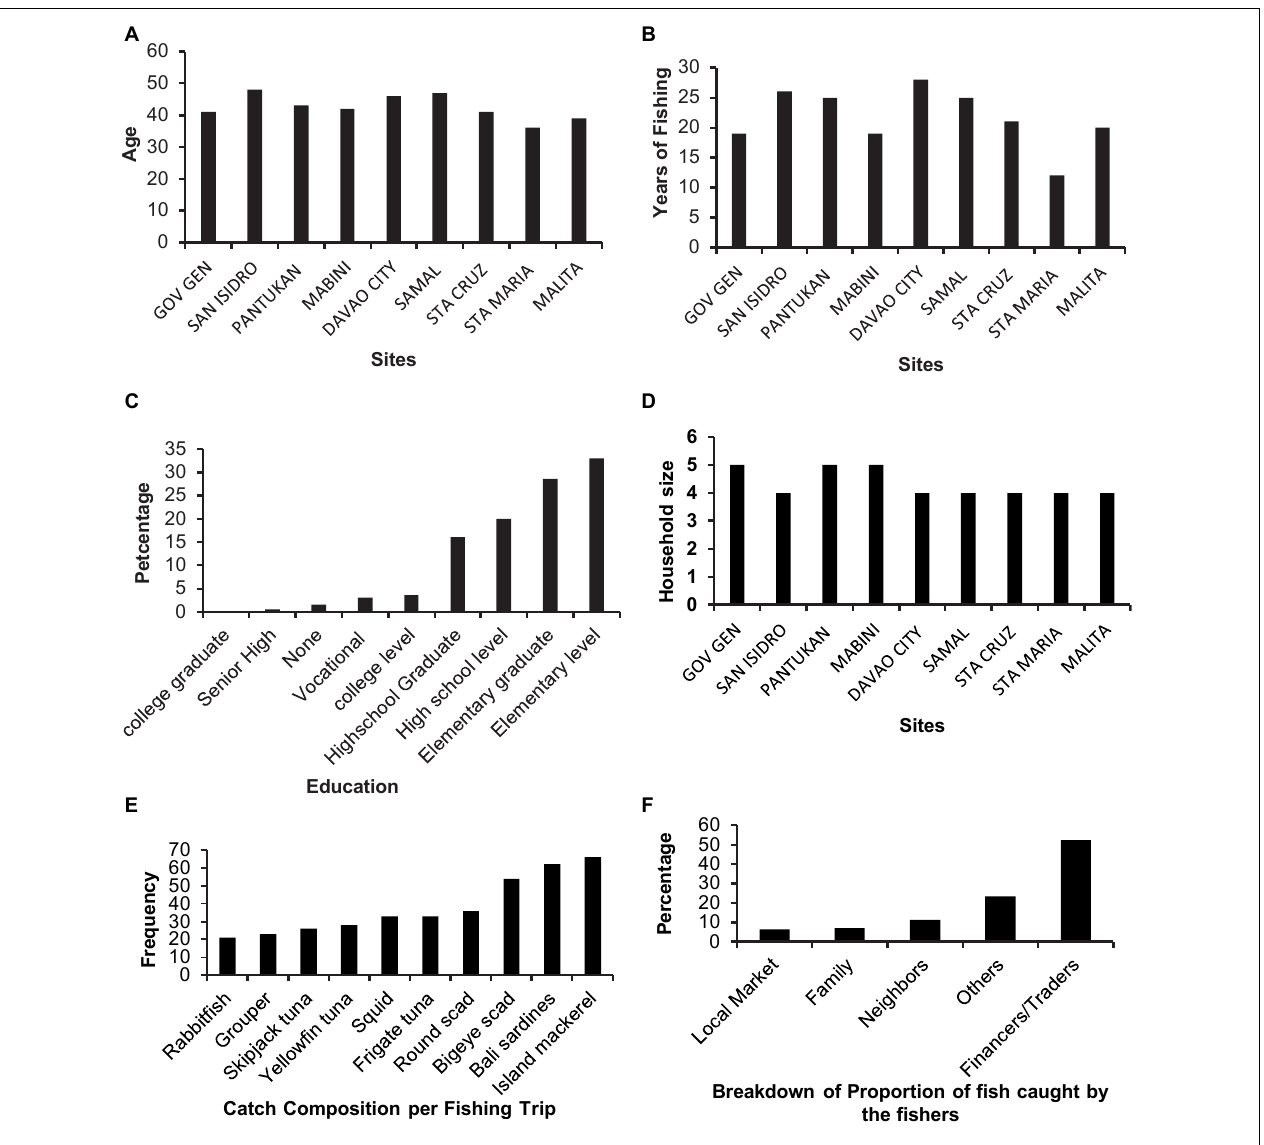
FIGURE 2 | Age of respondents (A) , household size (B) , years of education and (C) years of fishing (D) , catch composition (E) , and breakdown of proportion of fish caught by fishers (F) .